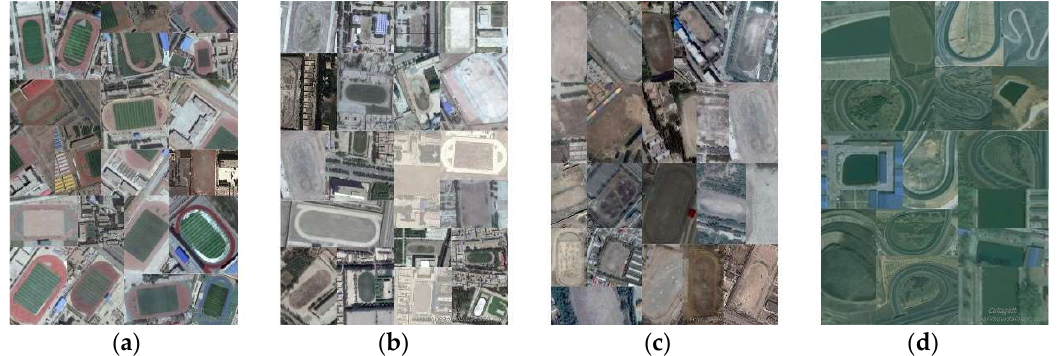
Figure 2. Patterns and confusing objects of Chinese track and fields. ( a ) Standard plastic track and fields; ( b ) track and fields made of cement concrete; ( c ) Soil track and fields; ( d ) Features that are easily confused with track and fields, such as overpasses, highway ramps, village trails, circular ponds, etc.